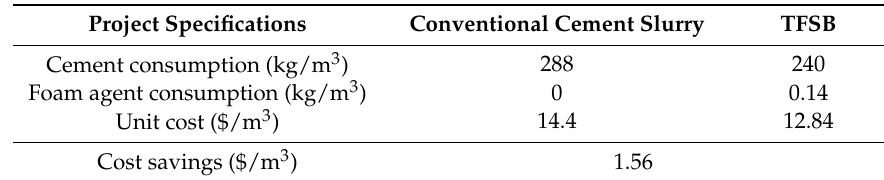
Table 7. The economic indicators for conventional backfill material and three-phase foam slurry backfill